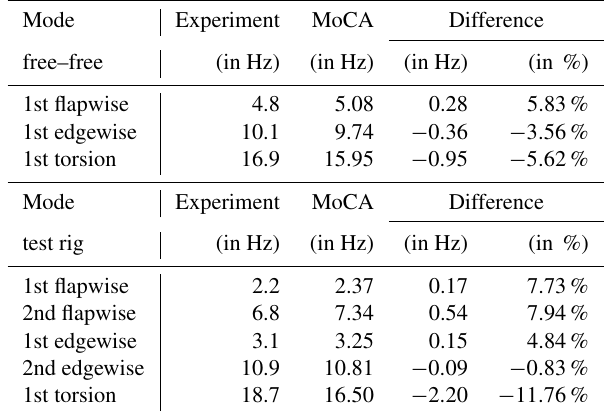
Table 2. Comparison of the modal analyses for the free–free (top) and the test rig (bottom) configuration. Experimental results are taken from Gundlach and Govers